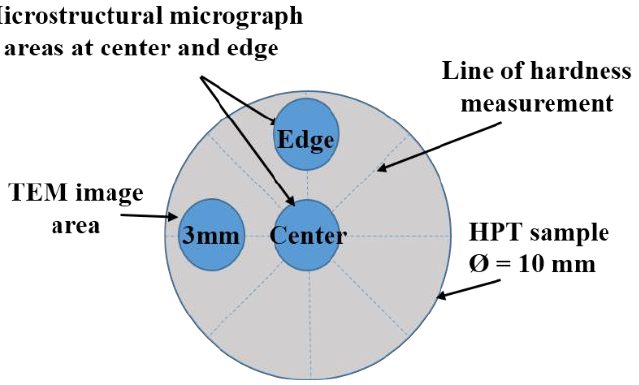
Figure 1. Schematic of ( a ) cooling slope casting, ( b ) ECAP die, and ( c ) HPT facility.